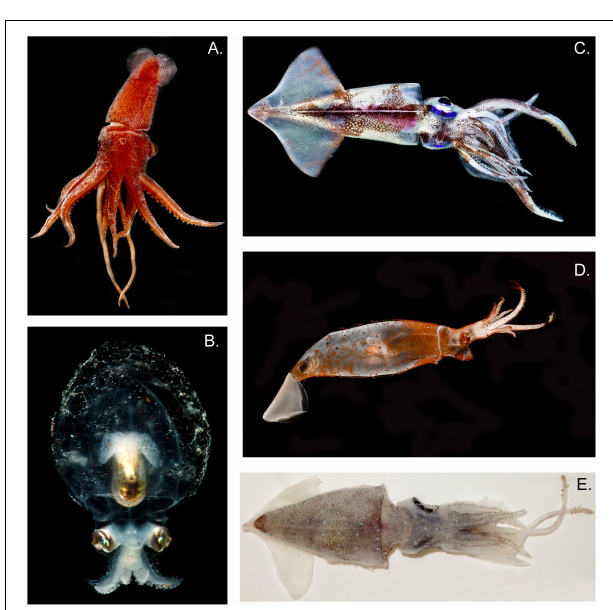
FIGURE 2 | Deep-sea cephalopod species analyzed in this study: (A) Histioteuthis corona, (B) Japetella diaphana , (C) Onychoteuthis banksii , (D) Leachia atlantica , and (E) Abralia redfieldi. Photo credit: D. Fenolio (A–D) and M. Vecchione (E) .